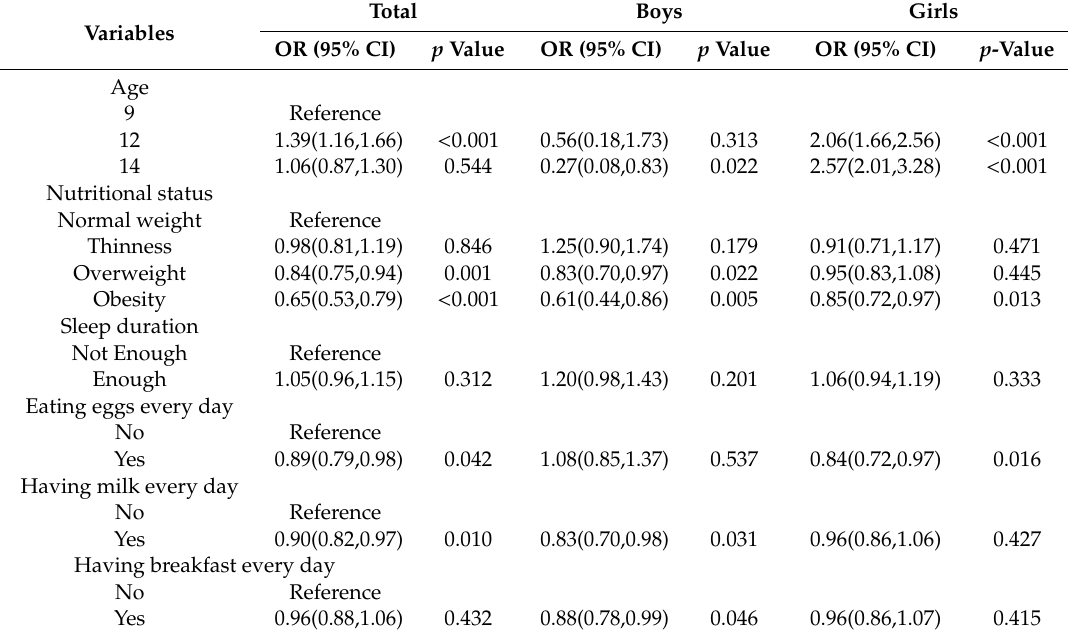
Table 5. Association between anemia and its risk factors in multivariate